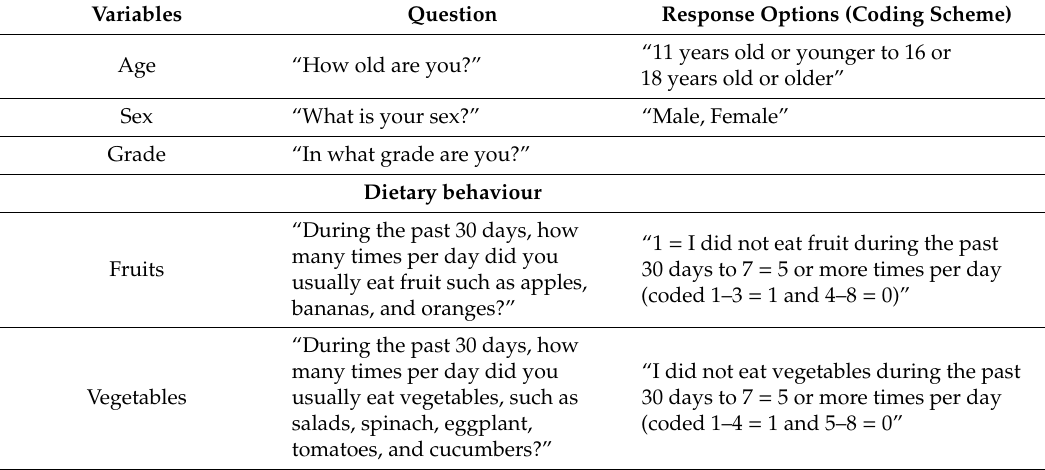
Table 1. Variable